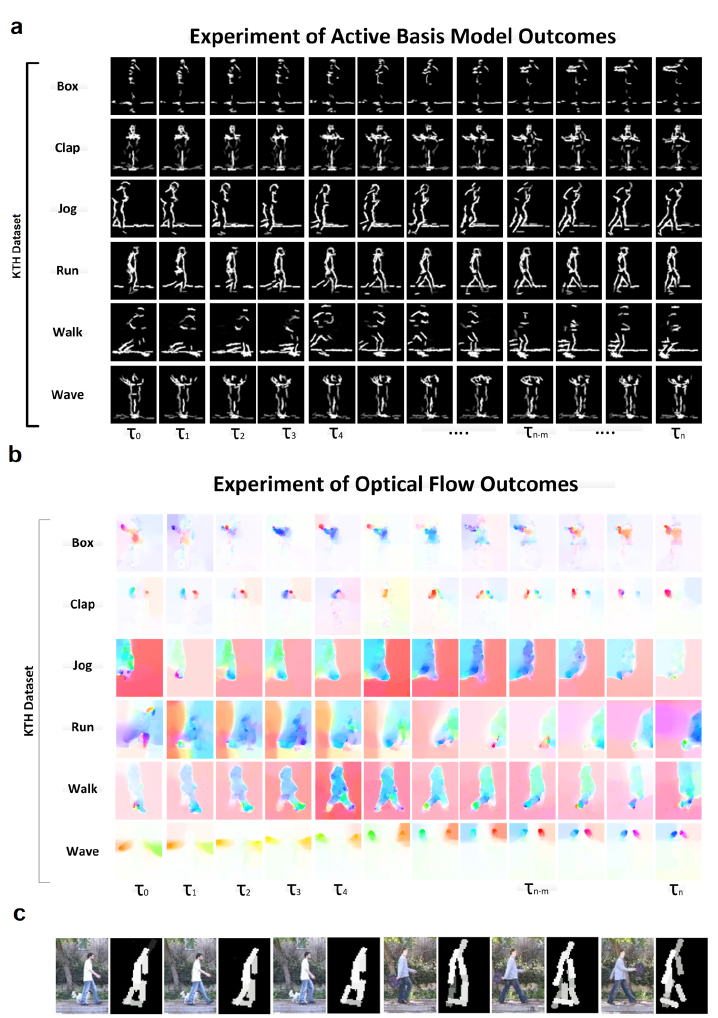
Figure 5. The resultsof simulation for a biological movement paradigm using ABM-based IncSFA modelled for form pathway ( a , c ) and motion pathway ( b ) by applying optical flow [127], are shown [16]. In ( a , c ) every row shows the response of ABM as well as the slowness features generated for actions. In ( b ) rows represent actions and a representation of motion information in false color